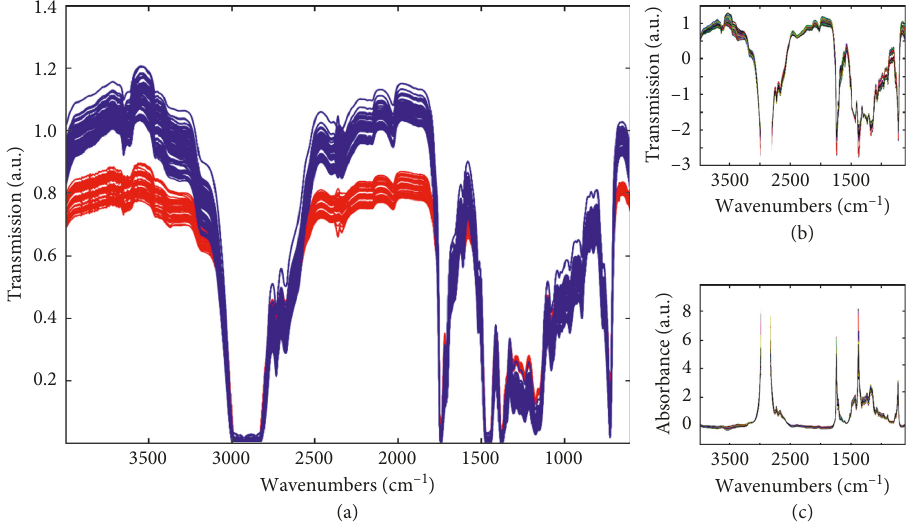
Figure 2: FTIR spectra of ATF B. (a) Raw full transmission spectra without any preprocessing. (b) SNV-transformed transmission spectra after truncation of the saturated C-H vibrational regions and CO 2 areas and (c) SNV-transformed absorbance spectra after